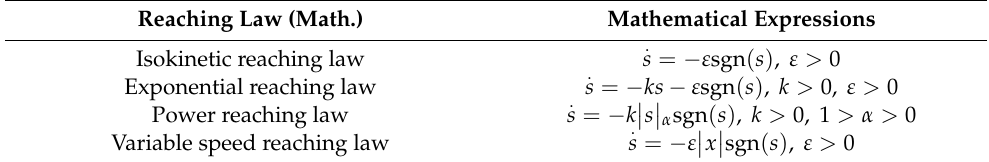
Table 3. Comparison of the four reaching laws. Reaching Law